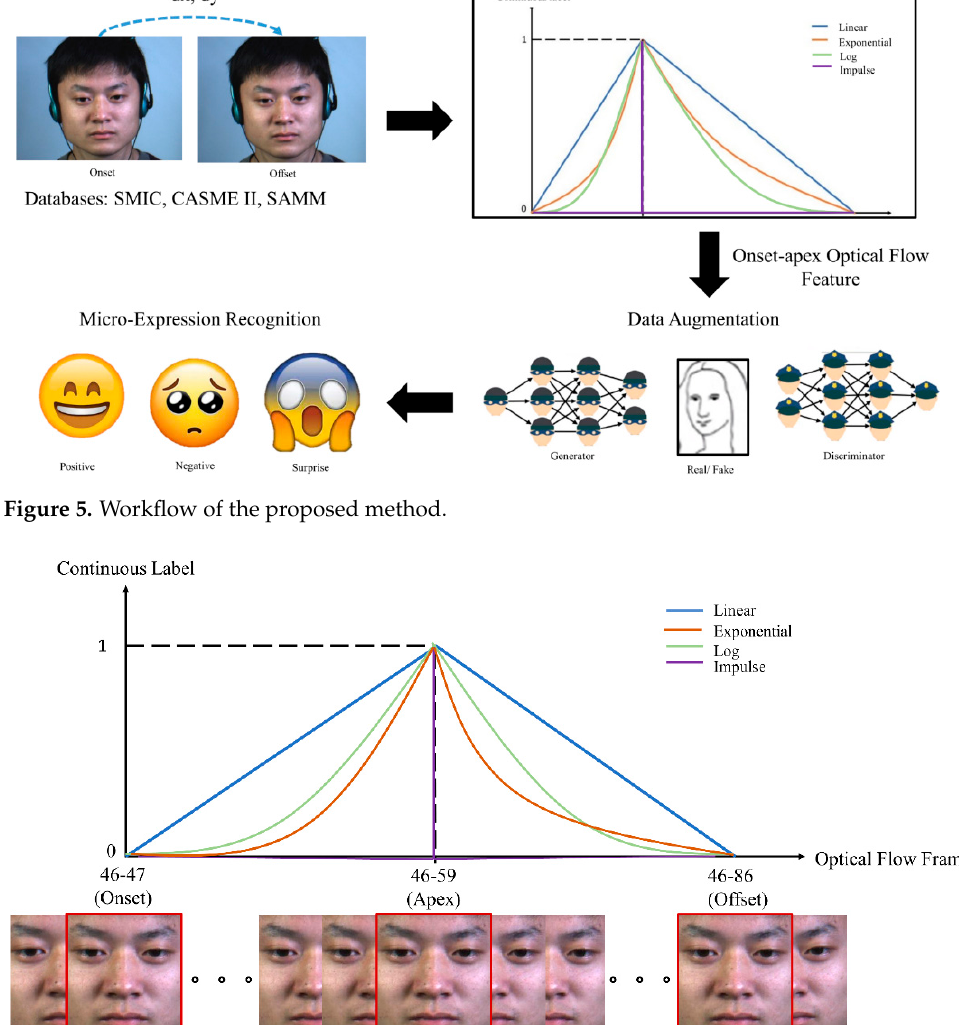
Figure 5. Workflow of the proposed method.